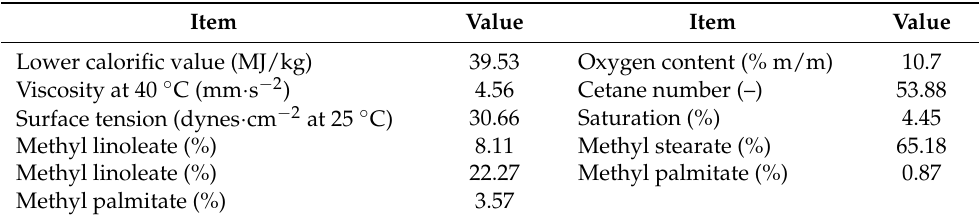
Table 1. Properties and Composition of rapeseed oil methyl ester (RME).